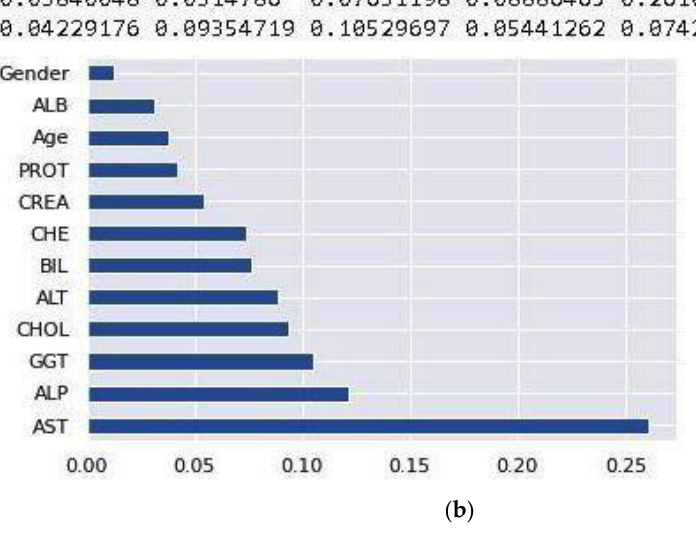
Figure 4. Feature importance based on the NHANES ( a ) and UCI ( b ) datasets. Table 2. Comparative result of the six machine learning algorithms on the NHANES dataset. In this research, the datasets were, respectively, split into 30% and 70% for the testing set and training set. To find a technique that is appropriate to predict hepatitis C, the re- sults of the six machine learning techniques are evaluated and compared. Tables 2 and 3 show the comparative result of the algorithms using two datasets. Precision, recall, and F1 score are listed for all the labels (0 means no hepatitis C and 1 means hepatitis C). Figure 5 shows ROC and AUC obtained by these six machine learning algorithms employing the